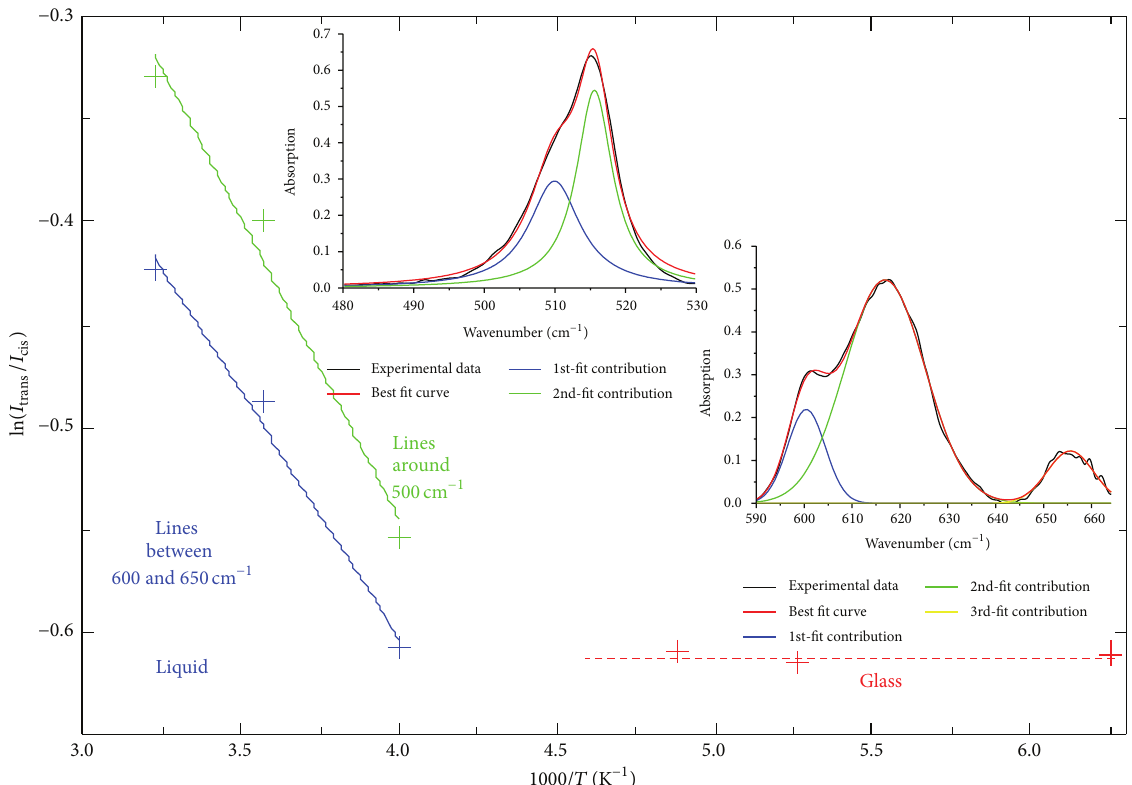
Figure 5: Temperature dependence of the ratio of the intensity of the vibration lines due to the transoid and cisoid conformers and best fit lines. In the inset two examples of the quality of the fit for the low frequency and high frequency lines are reported.